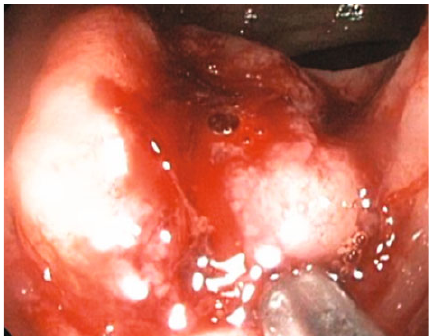
Figure 1: Colonoscopy showing a 4 cm fi rm mass fi rm with a depressed central